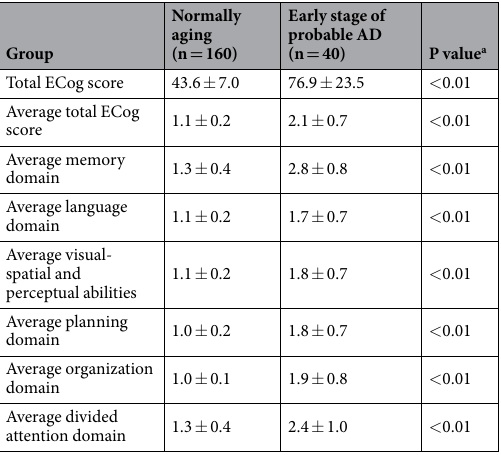
Table 2. Total ECog scores and average score of six domains in the two groups. Abbreviations: AD, Alzheimer’s disease; ECog, Everyday Cognition. Data was expressed as mean ± SD. a Tested by the Mann-Whitney U test.